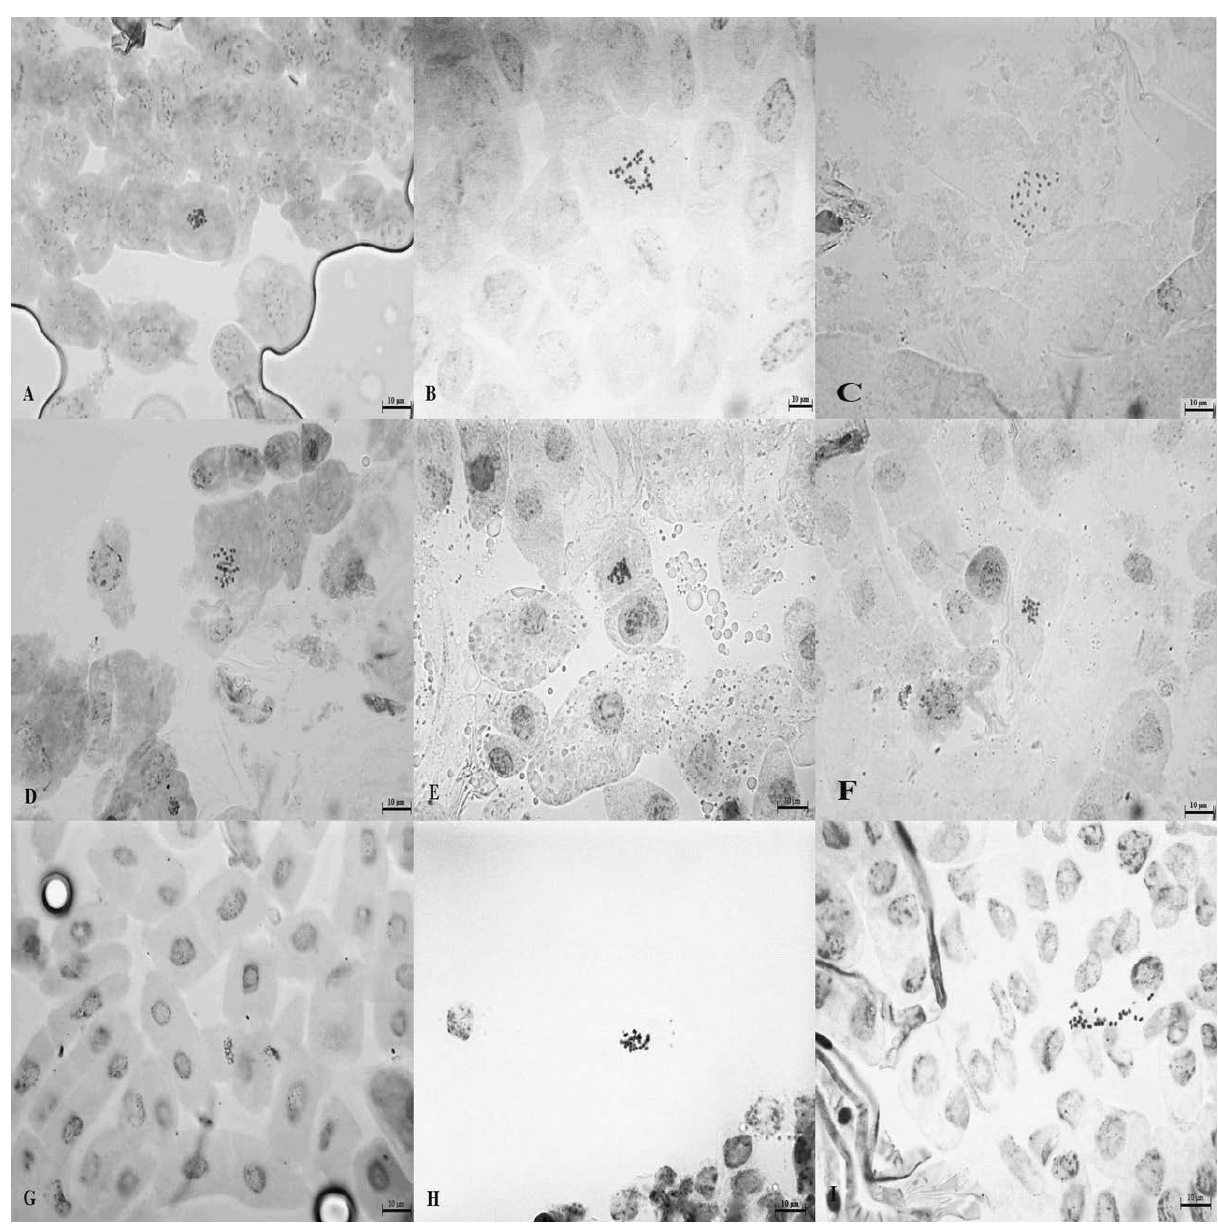
Figure 1A-I. Somatic metaphase chromosomes of Origanum taxa: A) O . ayliniae (TD4516) B) O . boissieri (TD4319); C) O .